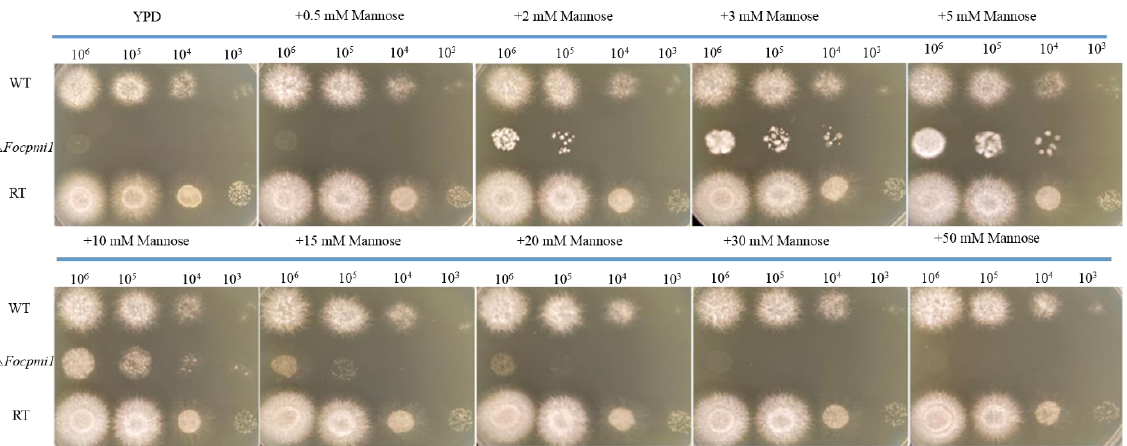
Figure 2. Growth of the WT, ∆ Focpmi1 , and RT strains on YPD supplemented with various concen- trations of mannose. Freshly harvested conidia were serially diluted (10 6 –10 3 ) and spotted on YPD media supplemented with 0, 0.5, 2, 3, 5, 10, 15, 20, 30, and 50 mM mannose. Plates were incubated at 28 °C for 48 h.